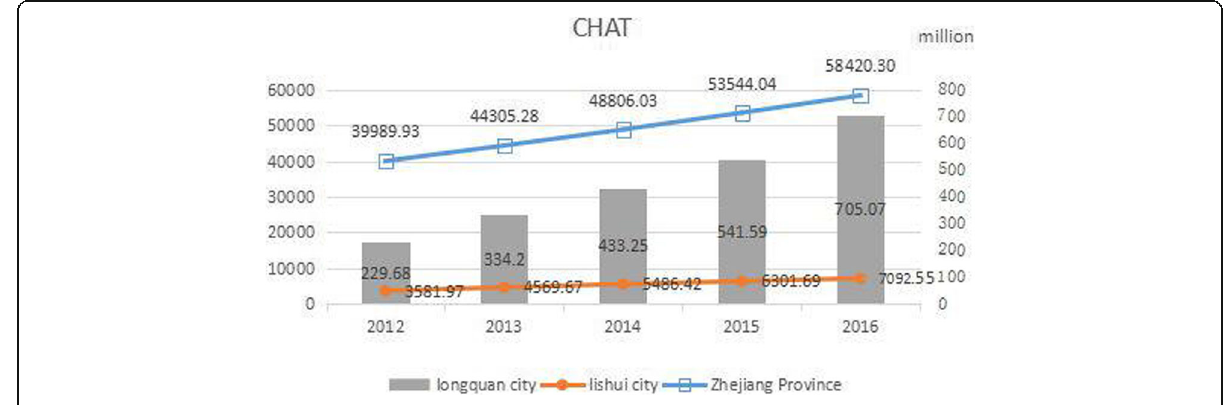
Fig. 2 The trend of the number of visitors in recent